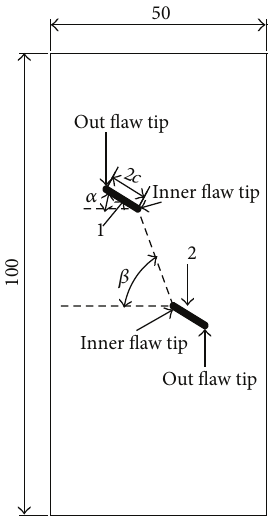
Figure 2: A specimen containing two preexisting flaws: the inclina- tion is 𝛼 , the rock bridge angle is 𝛽 , the length of the preexisting flaw is 2𝑐 , and the location of inner and outer flaw tips is